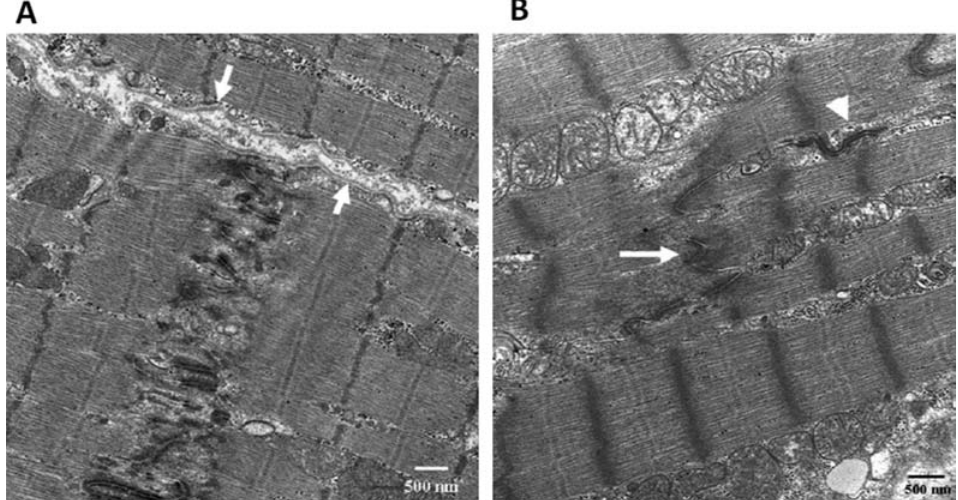
Figure 3. Electron microscopic view of cardiac myocyte intercalated discs. (A) Normal case control. Regular cell membrane (arrows) and intercalated disc between adjacent myocytes. (B) ARVC patient with desmoplakin gene splice site mutation. Note the abnormal position of long desmosomes (arrowhead) and the widened gap of facia adherens (arrow). Original magnification: X15 000. Adapted from Basso C. et al. Ultrastructural evidence of intercalated disc remodelling in arrhythmogenic right ventricular cardiomyopathy: an electron microscopy investigation on endomyocardial biopsies. Eur Heart J 27, 1847–1854